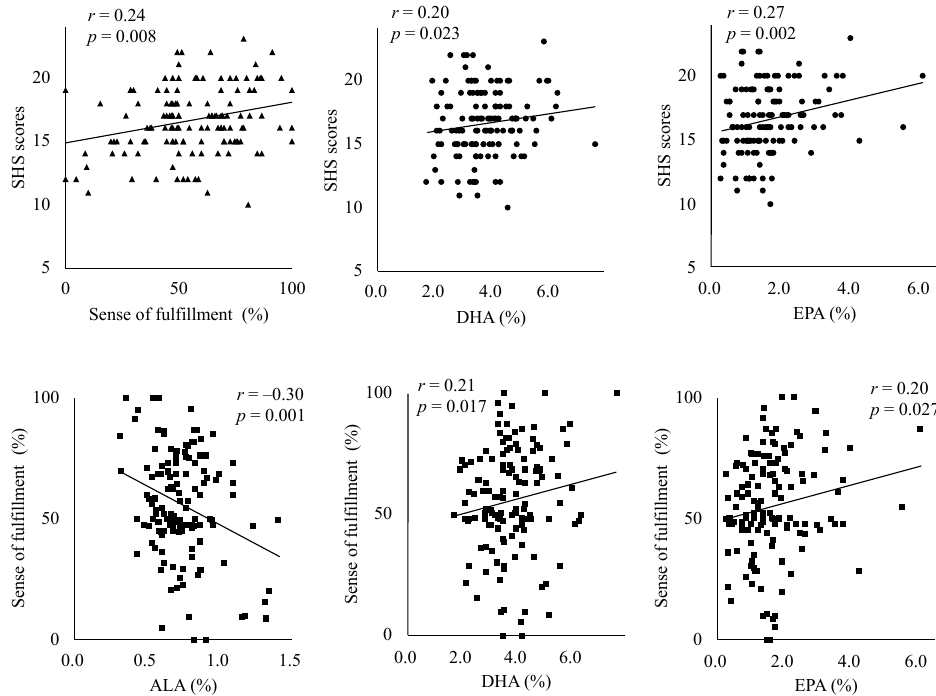
Figure 1. Significant partial associations between happiness as assessed by SHS, a sense of fulfillment, and fatty acid levels, adjusted for age, BMI, menopause, snacking habits, and leisure-time physical activities. The SHS scores showed significant positive correlations with a sense of fulfillment, DHA, and EPA percentage. ( p < 0.05, < 0.05 and < 0.005, respectively). A sense of fulfillment showed significant negative correlations with ALA percentage, and significant positive correlations with the percentages of DHA and EPA ( p < 0.005, < 0.005 and < 0.05, respectively). SHS: subjective happiness scale, LA: linoleic acid, EDA: eicosadienoic acid, ALA: α -linolenic acid, DHA: docosahexaenoic acid, EPA: eicosapentaenoic acid.